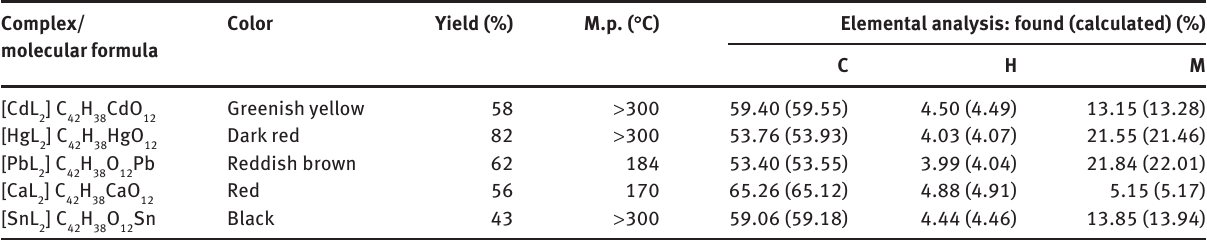
Table 1 Physical and analytical data of the metal complexes of curcumin. Complex/ molecular formula